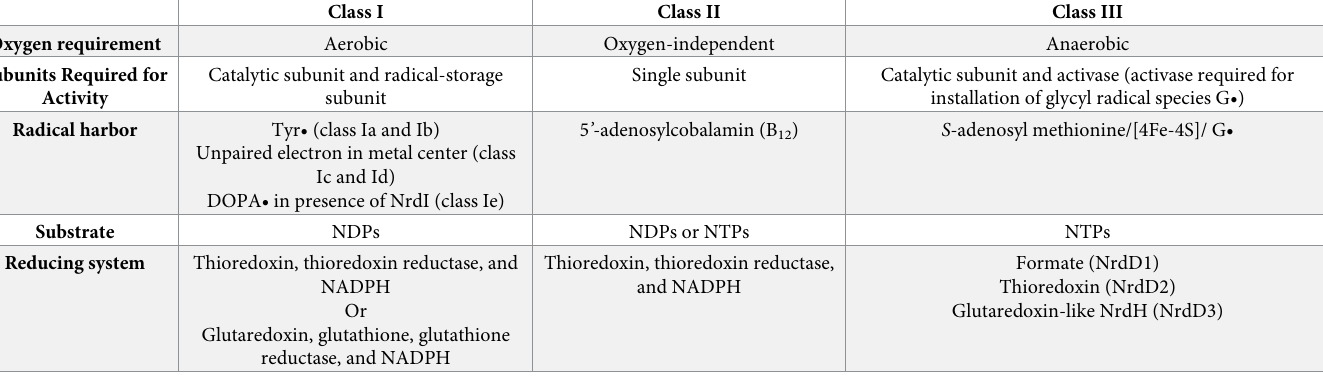
Table 1. Comparison of class I, class II, and class III RNRs highlighting the differences that make a universal activity assay challenging. Subclasses of class III RNRs are listed as NrdD1, NrdD2, and